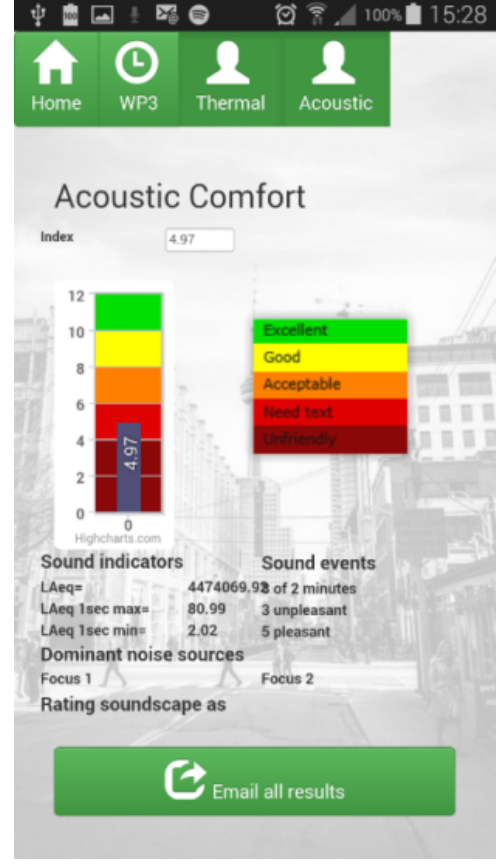
Figure 3: Acoustic app.